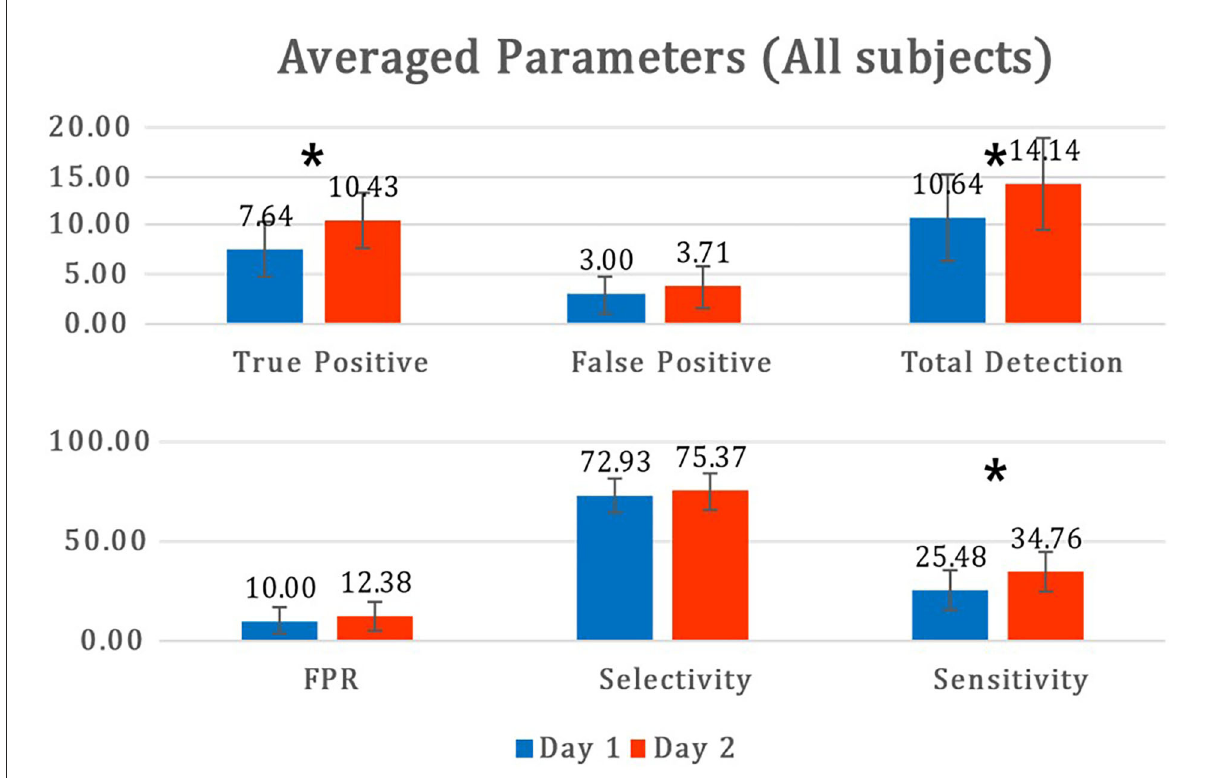
FIGURE9 Mean and standard deviations of parameters between day 1 and day 2. The asterisk (*) is statistically significant (p < 0.05) between days. FPR, false positive ratio.